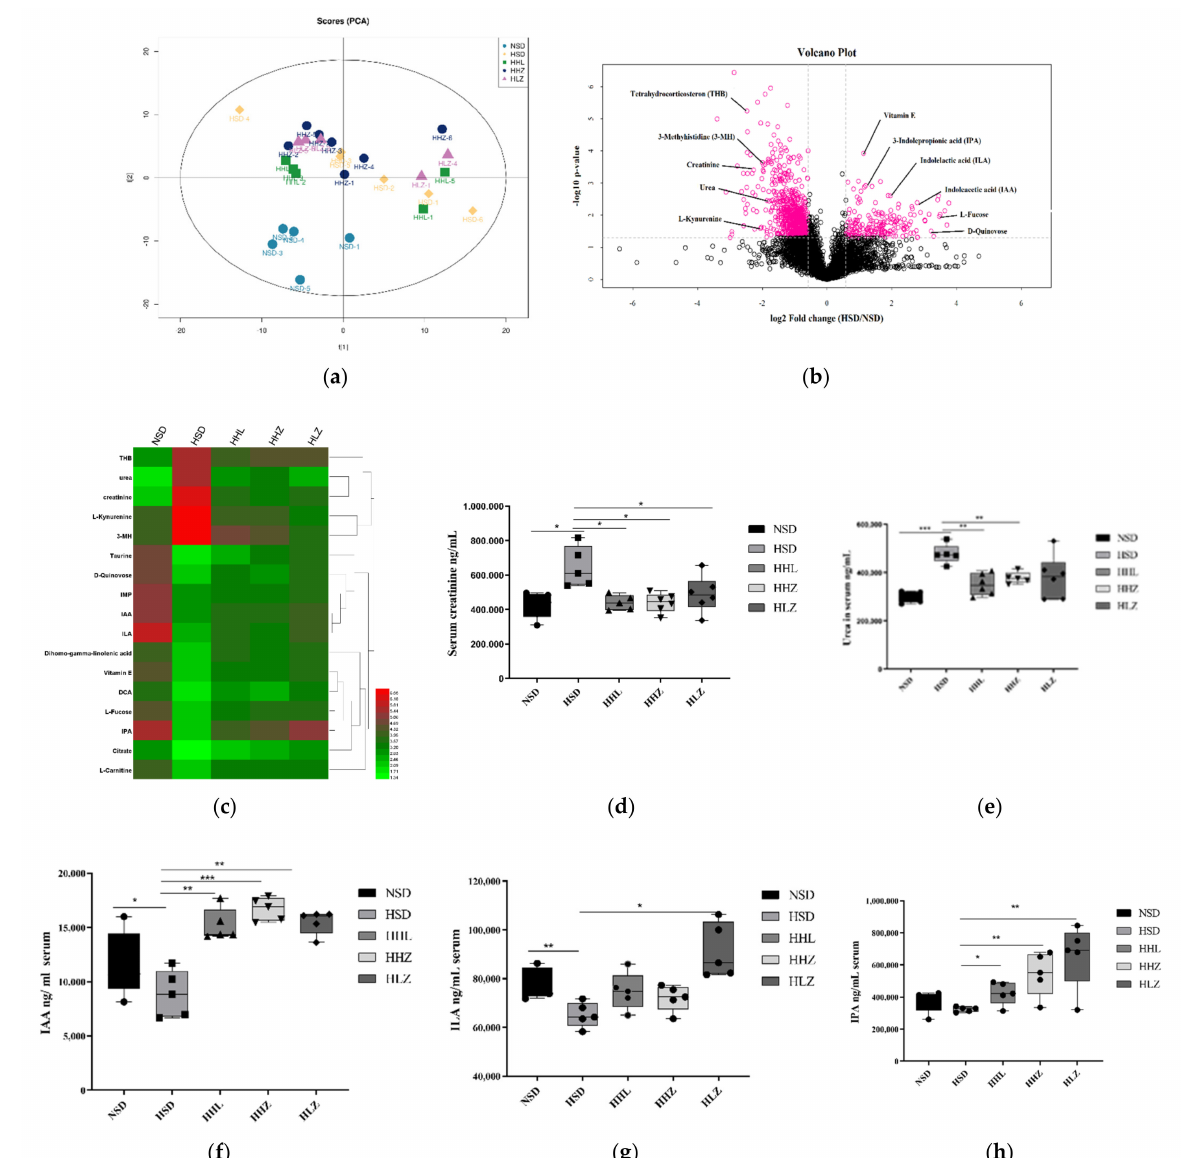
Figure 3. Lactobacillus plantarum ZDY2013 can reduce the concentration of urinutoxin increased by HSD. ( a ) Positive and negative ion mode samples of PCA score. ( b ) Volcanic positive ion mode (Volcano Plot), the red dots are differential metabolites screened by univariate statistical analysis. ( c ) Clustering heat map of metabolites with partial significant differences in different groups. ( d ) Serum creatinine concentration in different groups. ( e ) Serum urea concentration in different groups. ( f – h ) Serum IAA, ILA, and IPA concentration in different groups. THB: tetrahydrocorticosterone; PAA: phenylacetic acid; IAA: indoleacetic acid; ILA: indolelactic acid; IPA: indolepropionic acid; DCA: deoxycholic acid; IMP: inosine 5 (cid:48) -monophosphate; HPAA: hydroxyphenylacetic acid. All data are presented as mean ± SD. * p < 0.05; ** p < 0.01; *** p < 0.001. Square: HSD group; circle: NSD group; triangle: HHL group; upside down triangle: HHZ group; rhombus: HLZ